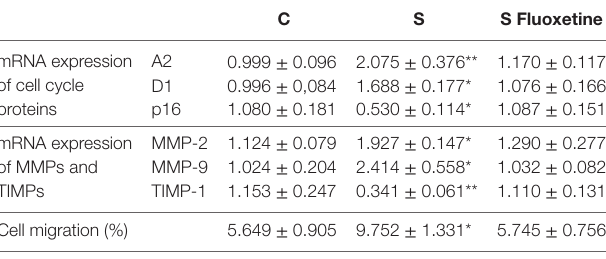
Quantitative real-time reverse transcription polymerase chain reaction was performed in cDNA obtained from purified tumor cells suspensions from control (C), stressed (S), and fluoxetine-treated stressed (S Fluoxetine) mice. mRNA relative expression was quantified using β 2 -microglobulin as housekeeper. Moreover, isolated cells from solid tumors were seeded in the upper well of transwell migration chamber and RPMI with 10% FBS as attractant. After 24 h, cells in the upper and in the lower chamber were counted. Cell migration is presented as percentage of total cell count for each sample. Values are expressed as mean ± SEM. n = 5 mice per group. *p < 0.05, **p < 0.01 respect to control